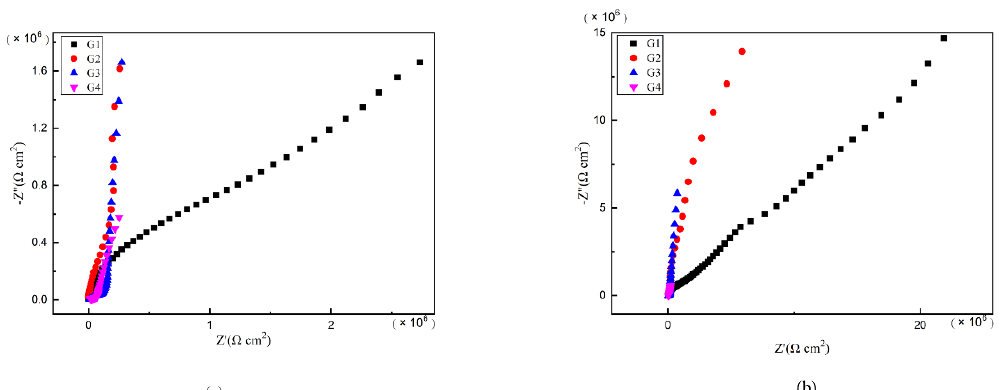
Figure 6. Each EP/CeO 2 -GO coating’s Nyquist pattern for immersion for 2 d: ( a ) Nyquist patterns for 2 d; ( b ) amplification of Nyquist patterns for 2 d.